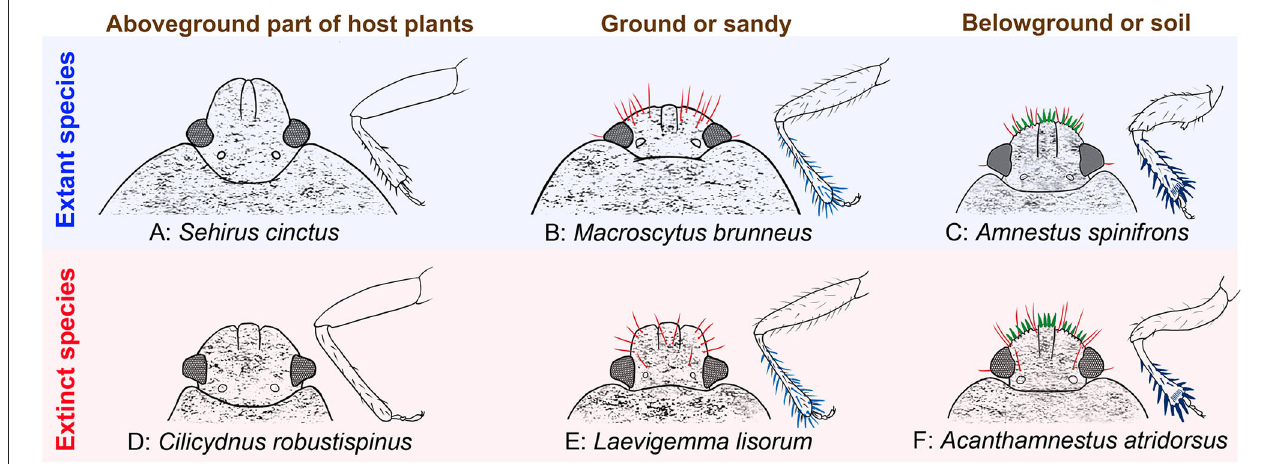
FIGURE 10 | Three morphotypes corresponding to three different habits in extant and extinct